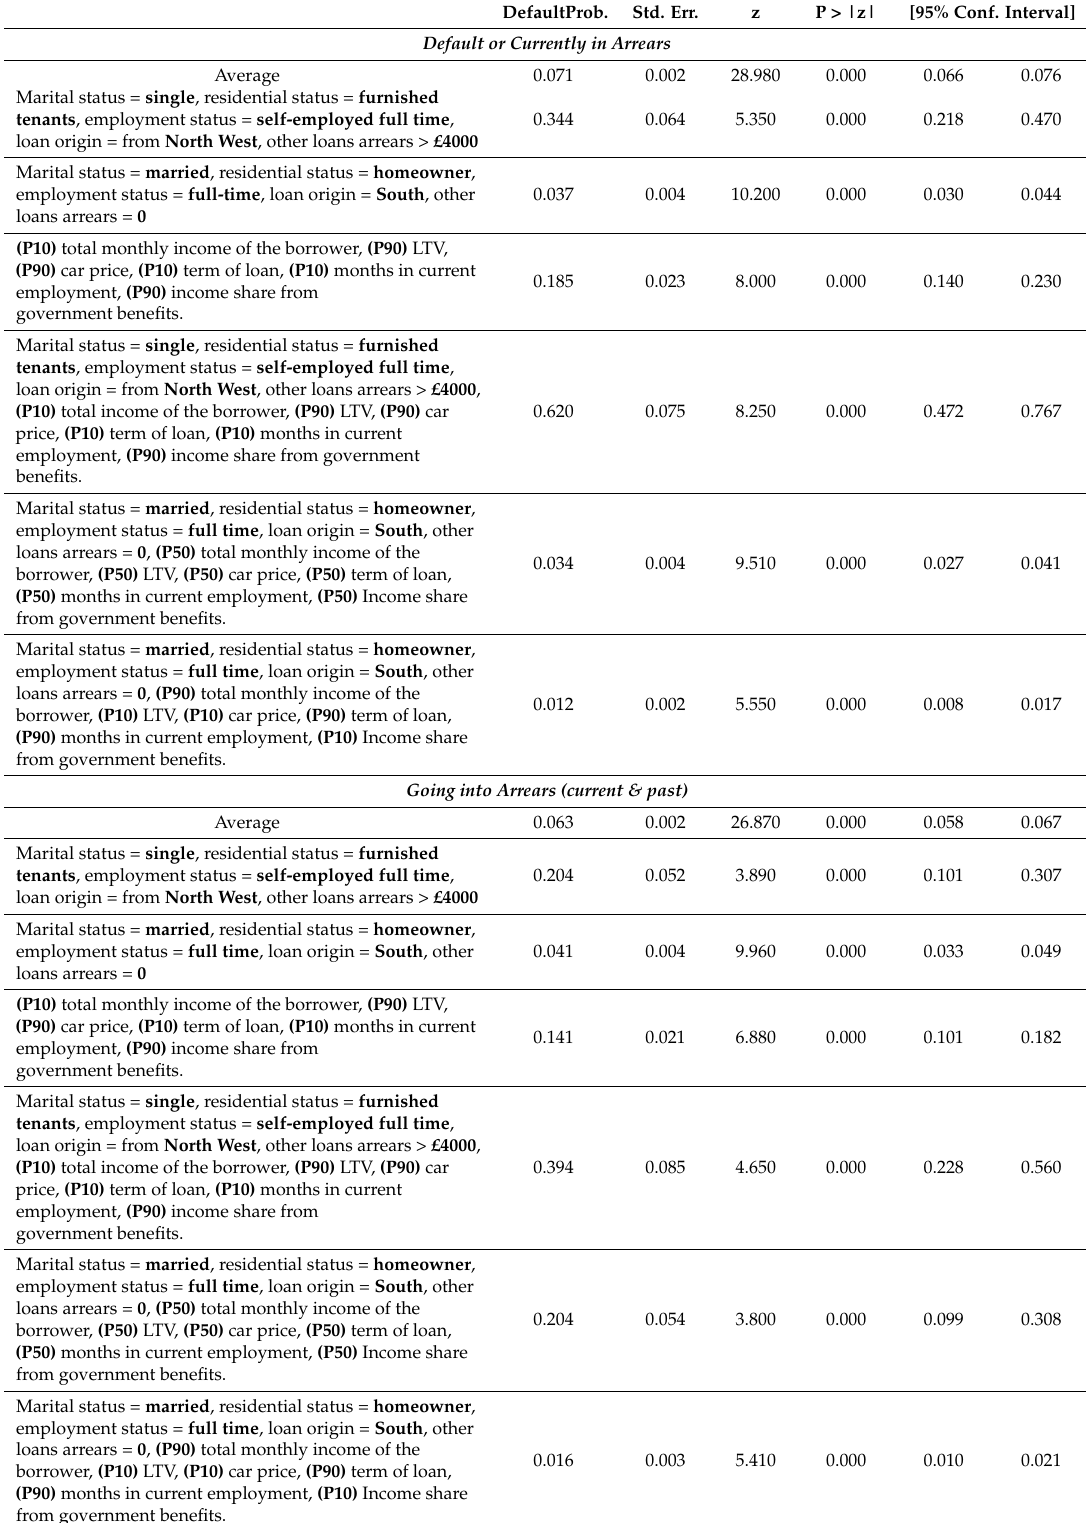
Table 8. Subprime automobile loans: predicted default/arrears probabilities with different